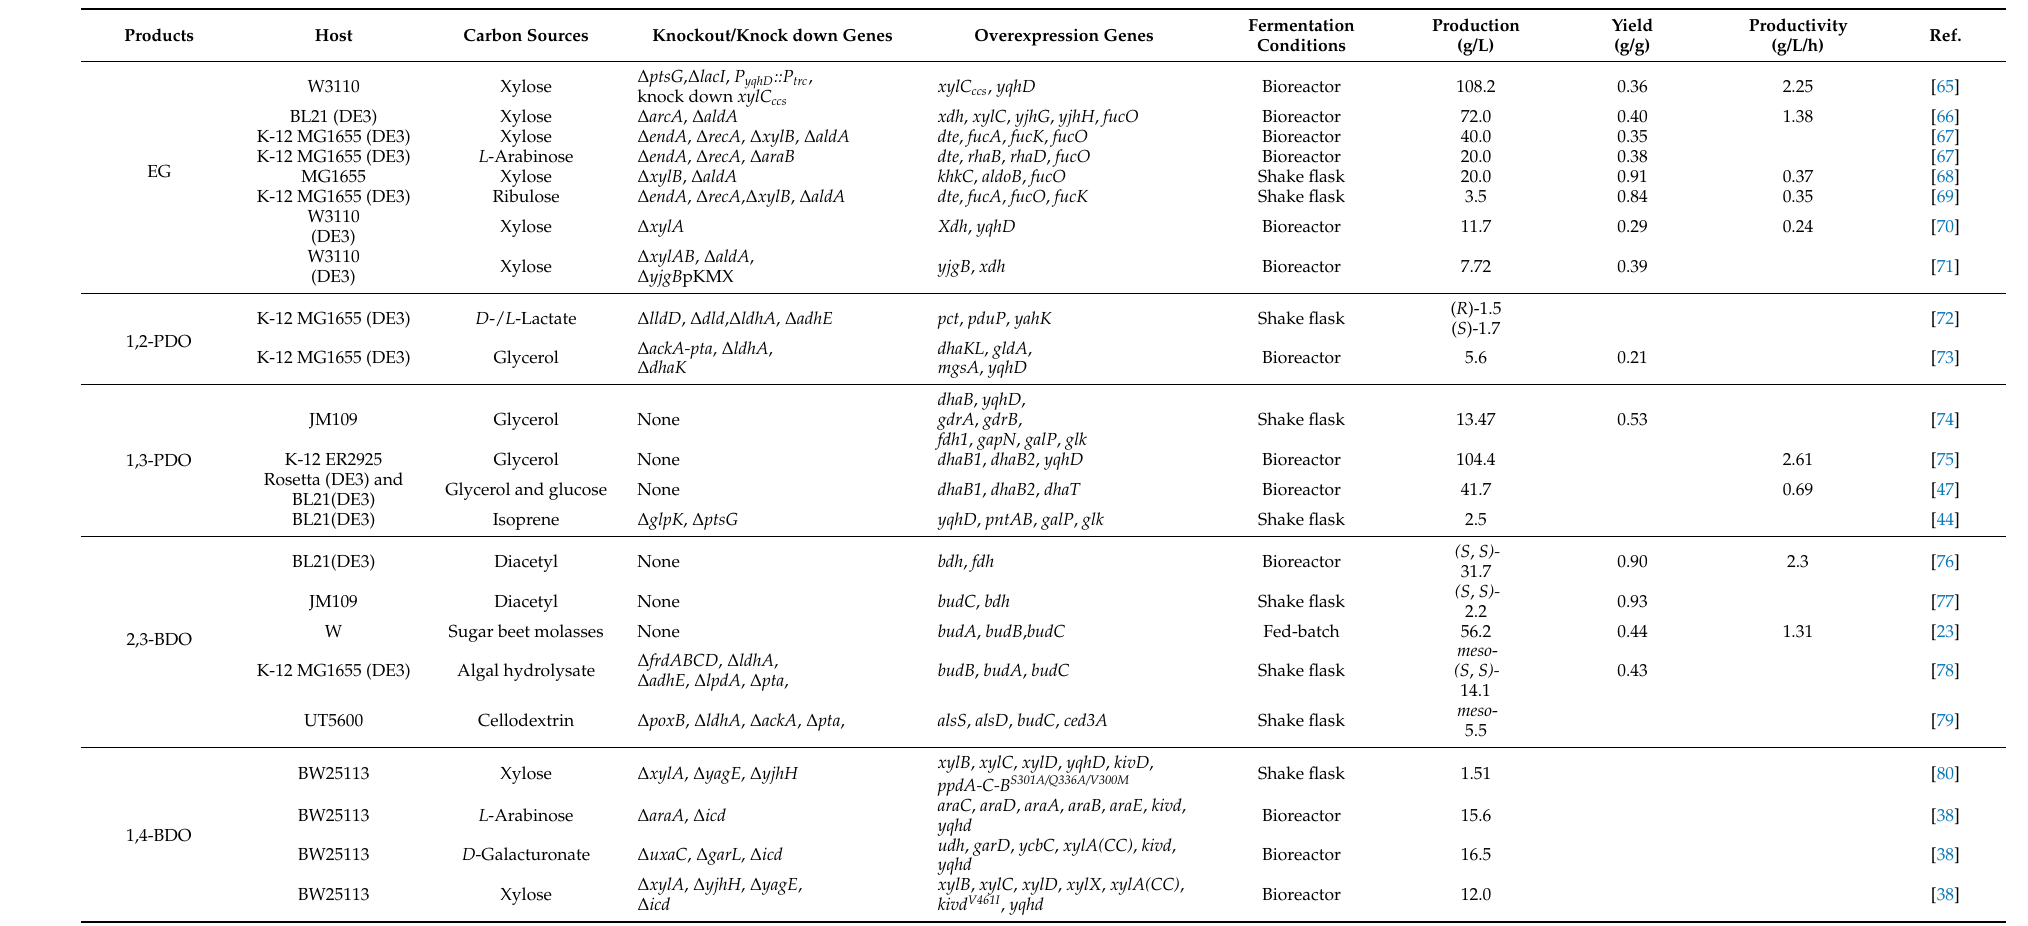
Table 2. Summary of diols production from other carbon sources in E. coli